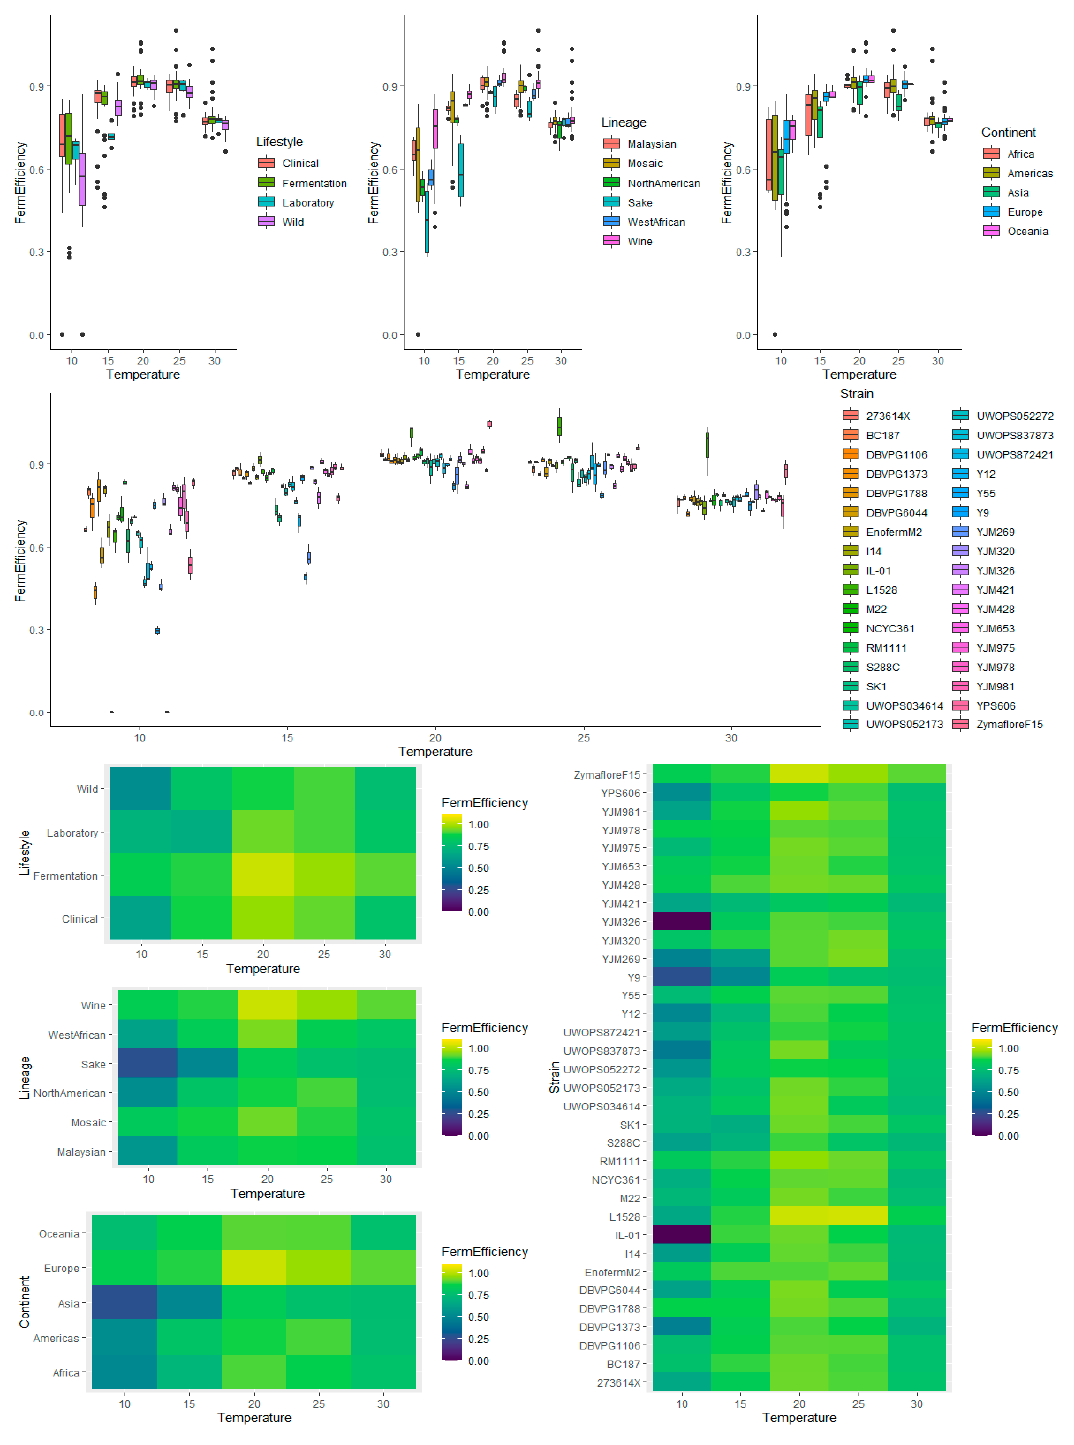
Figure 8. Box plots (top) and heatmaps (bottom) visualizing the interaction of temperature and each of the factors investigated (lifestyle, lineage, continent, and strain) on fermentation